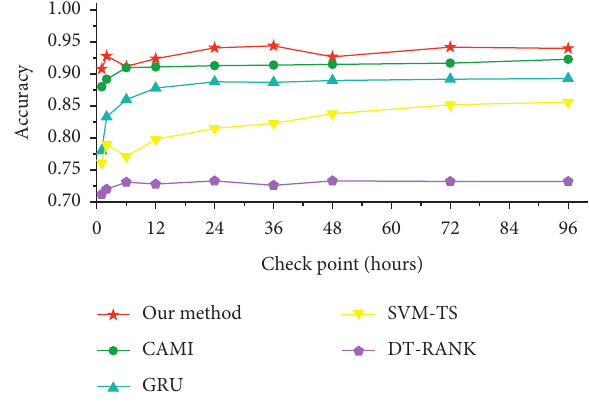
Table 7: Early detection of rumor (R: rumor; N: nonrumor). Deadline (h)